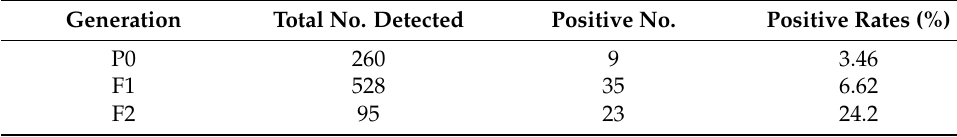
Table 2. PCR results of transgenic